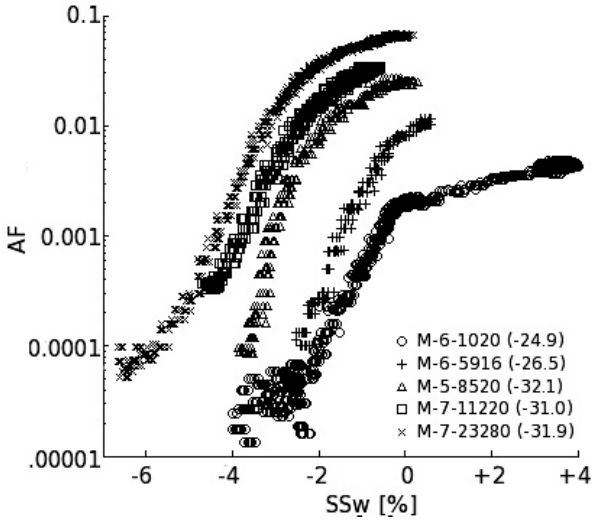
Fig. 9. Arizona test dust SS-scans performed by the MINC instru- ment. Legend: “M” – MINC instrument results, first number: sam- ple preparation number, second number: seconds from the start of the experiment at which the scan began, number in brackets: tem- perature at which the scan was performed.